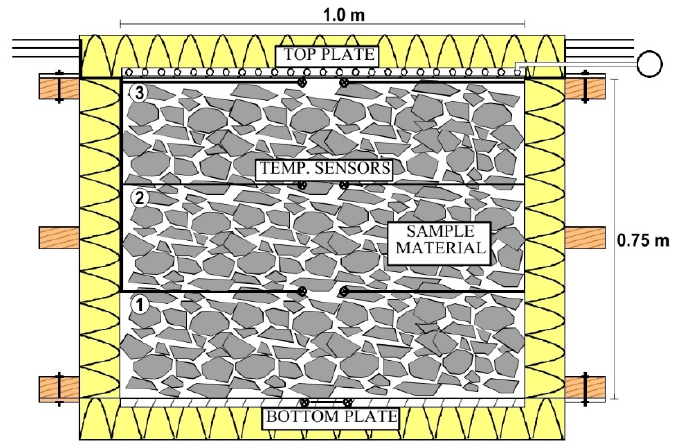
Figure 7. Center cross-section of experimental setup used by NGI (Goering et al., 2000 [4]).